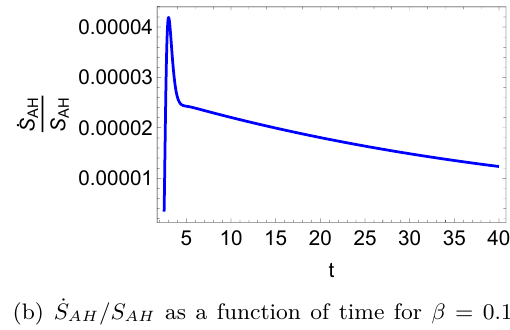
and initial conditions set by (4.16).